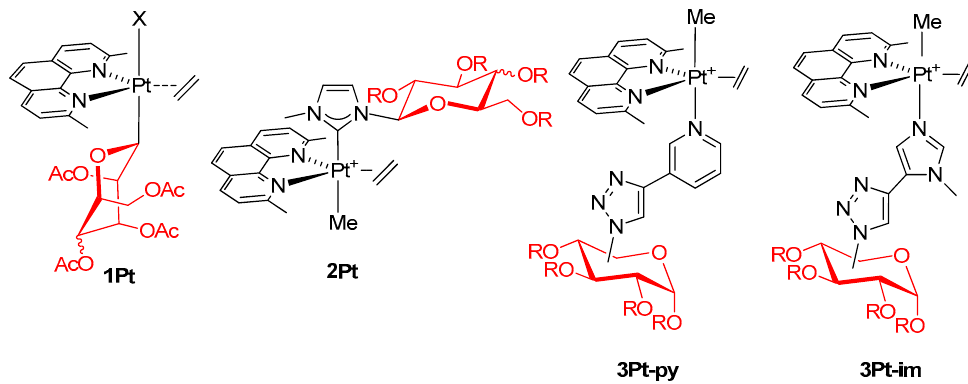
Figure 1. Structure of the five-coordinate platinum(II) complexes 1Pt , 2Pt , and 3Pt (R=H, OAc).